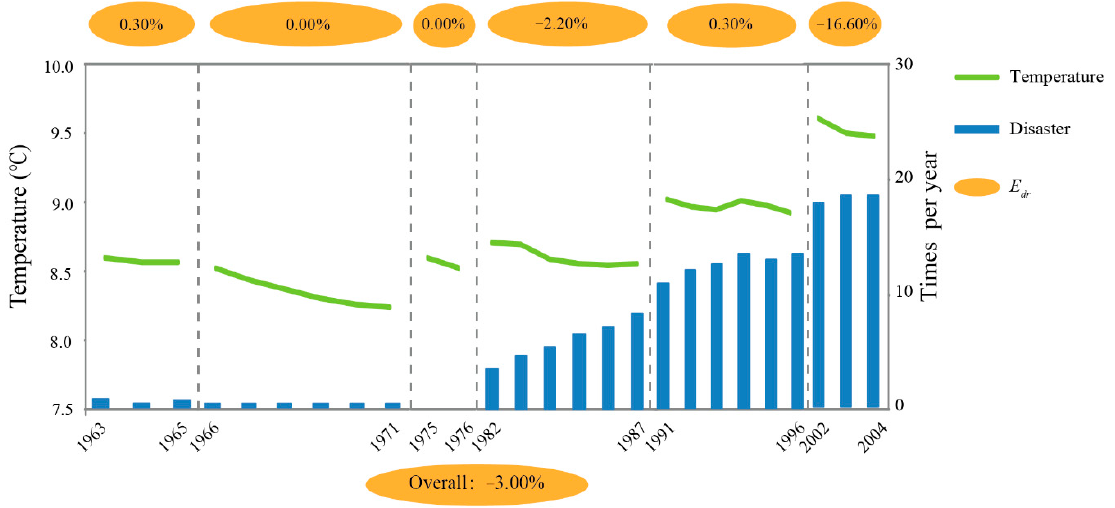
Figure 6. The arc elasticity coefficient ( E dr ) of 5-YMAT and ACND during temperature-drop periods. The coefficient values for each temperature cycle period are shown in the ovals above the figure. The corresponding coefficient for the entire temperature-rise period is shown in the oval below the figure.